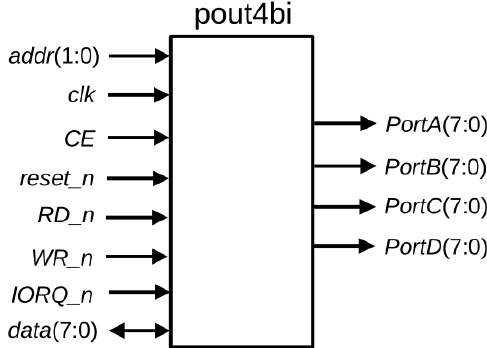
Figure 6. pout4bi